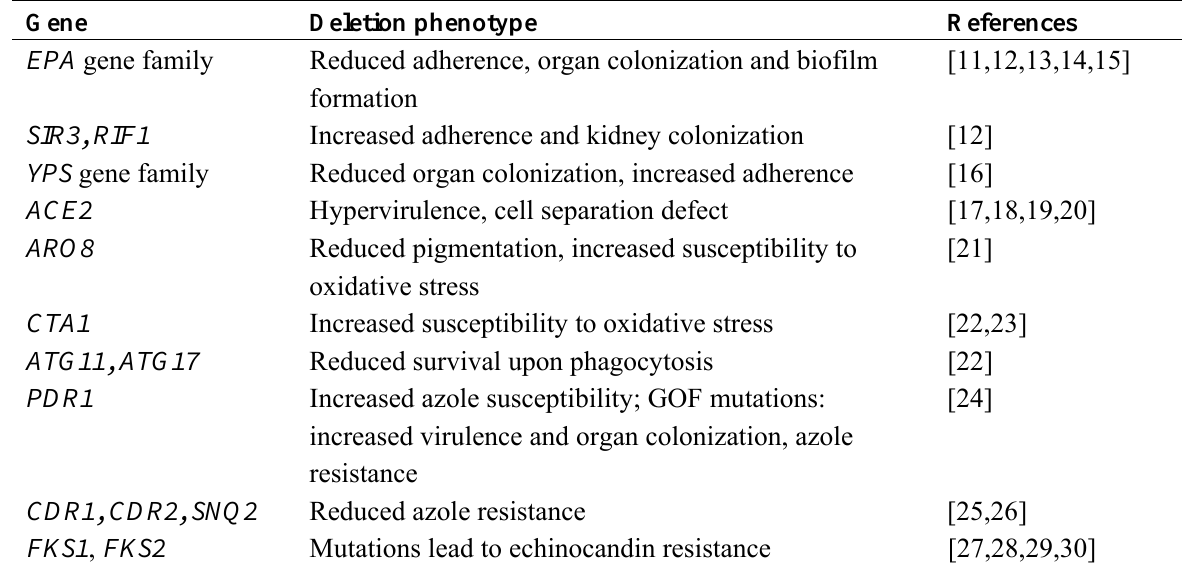
Table 1. Candida glabrata genes implicated in pathogenicity and